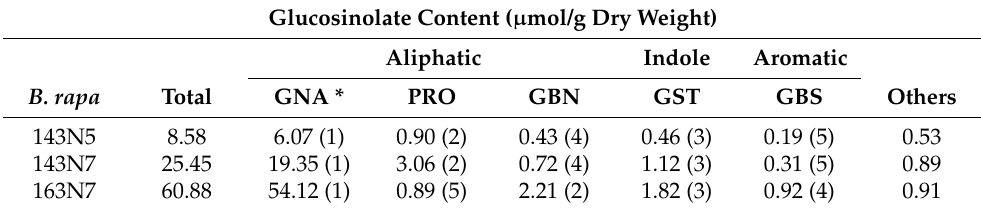
Table 2. Glucosinolate content in analysed Brassica rapa